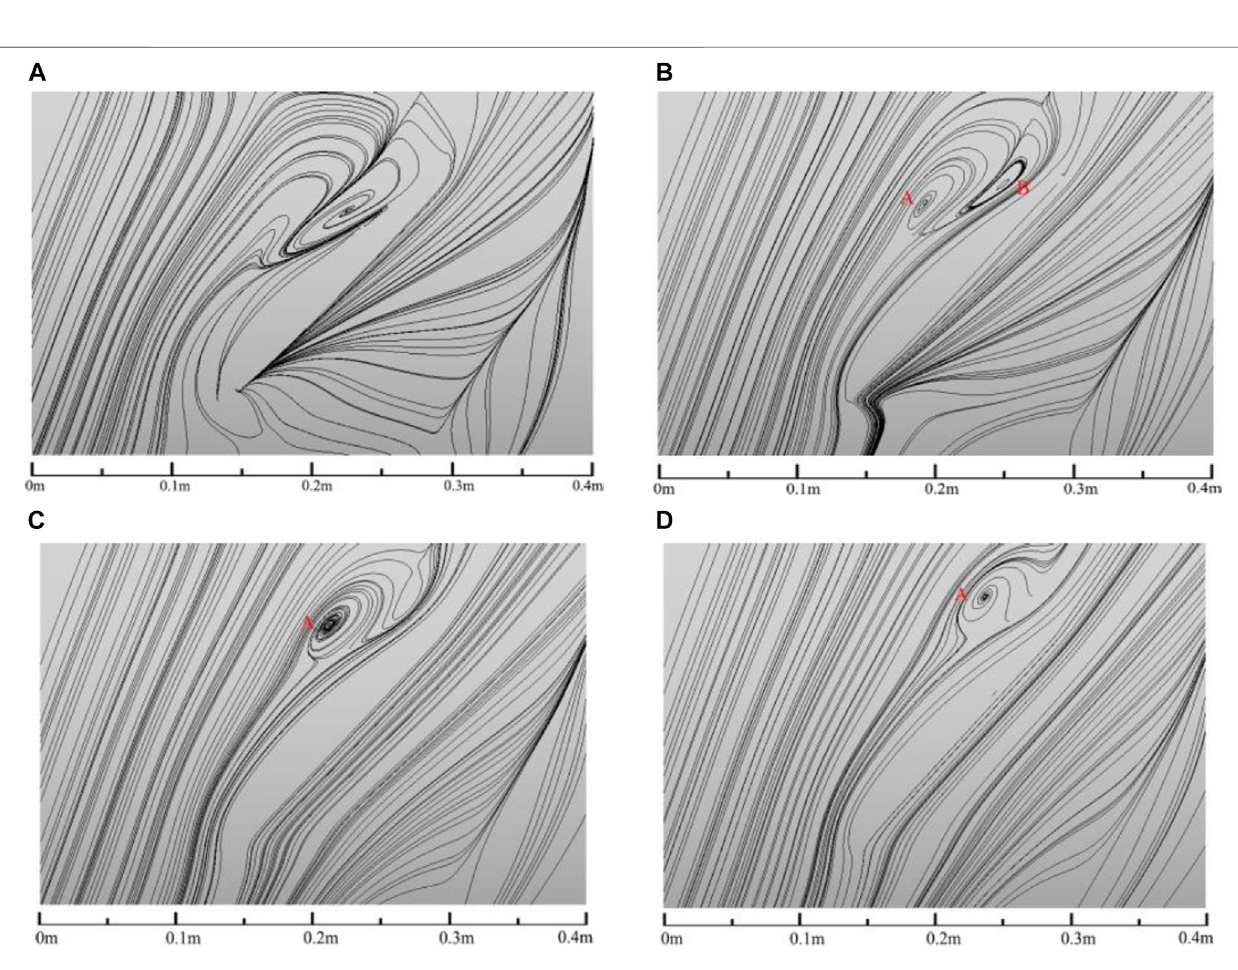
Frontiers in Energy Research |